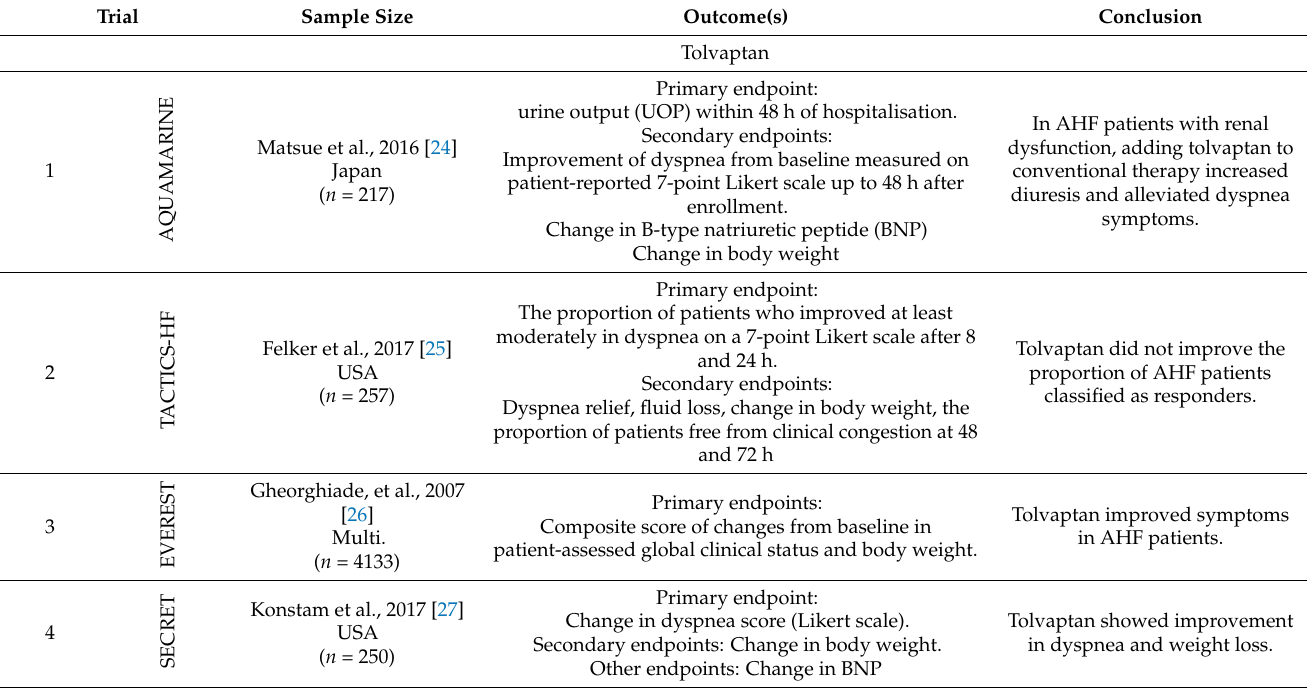
Table 1. Summary of studies investigated vasodilatory